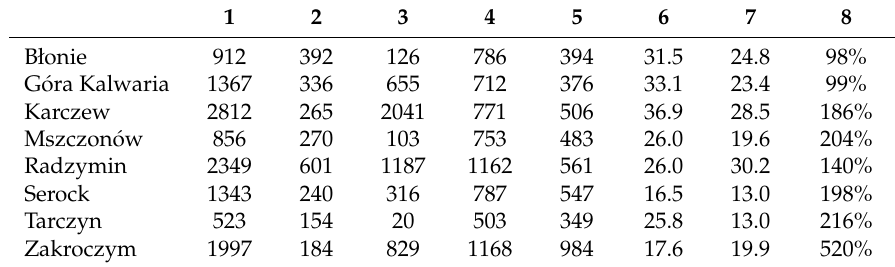
Table 6. List of urbanized areas in 2018 and areas intended for urbanization according to the planning documents of the studied cities. Source: own